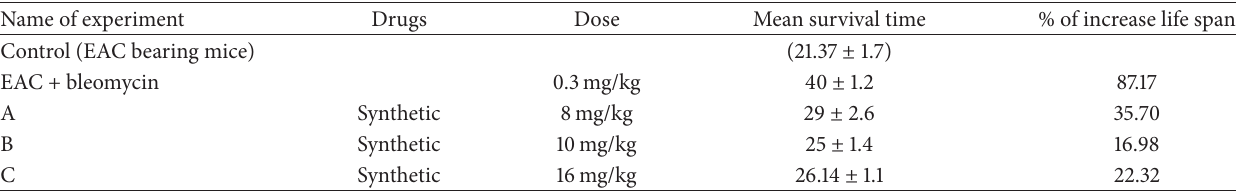
Table 5: The effect of test compounds on survival time of EAC cell bearing mice.